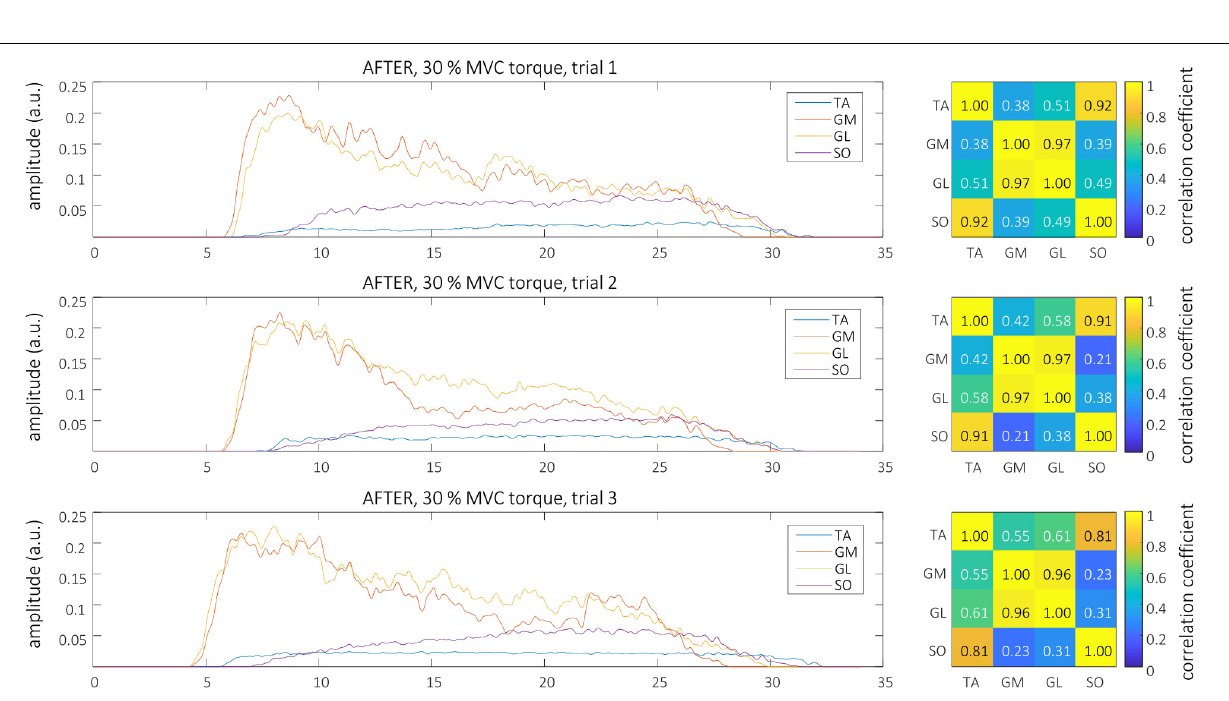
FIGURE 2 | Left, CSTs as calculated from the tibialis anterior (TA), gastrocnemius medialis (GM), gastrocnemius lateralis (GL), and soleus (SO) muscles of older participant (O1) during the three trials at 30% MVC torque after the bed rest. Right, The muscle coactivation as revealed by the cross-correlation analysis of CSTs of different